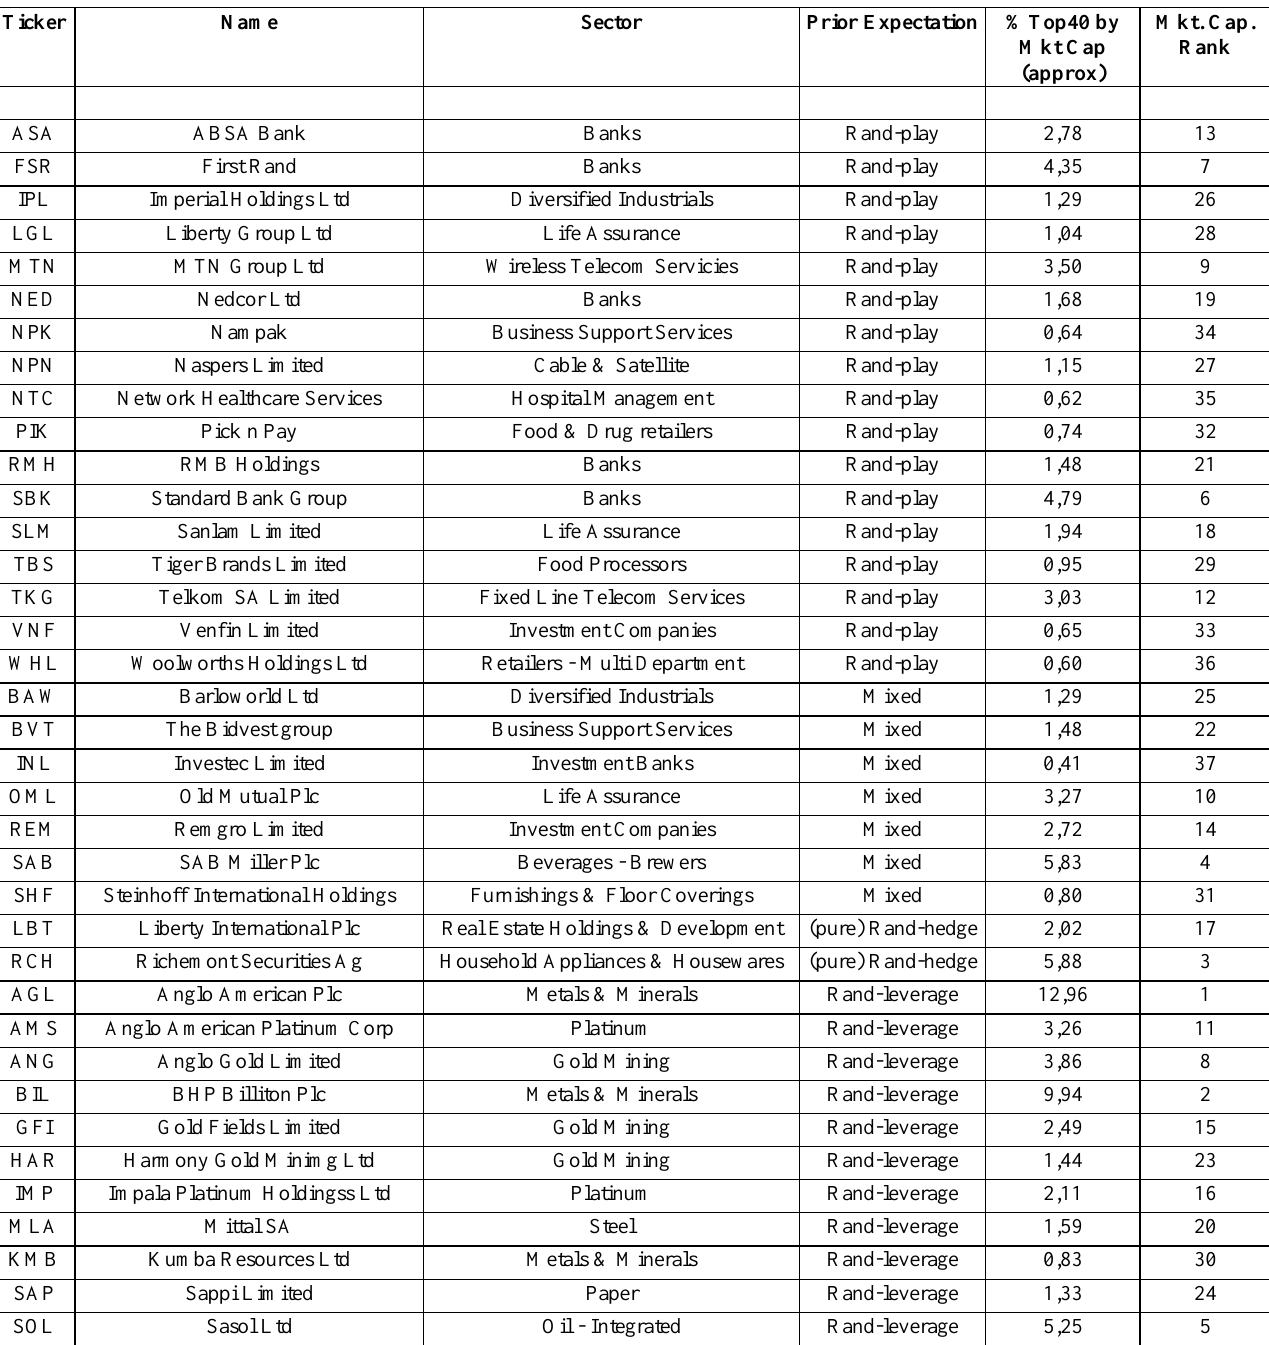
Table 1: Sample of shares considered